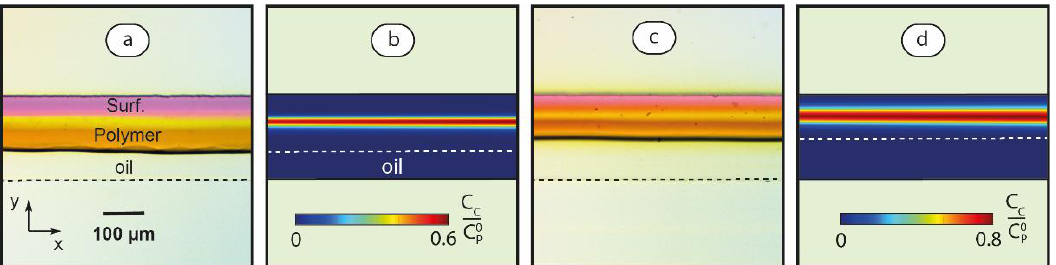
Figure 8. Optical microscopy images and numerical simulation results for PDADMAC-SDS association in linear threads at Ca ≈ 0.05 and different flow rate ratios: φ = 3 ( a , b ) and φ = 1 ( c , d ). C C is the concentration of surfactant ions bound to macrochain binding sites, C P0 is the total concentration of macrochain binding sites. (phenolphthalein + 0.01 M KOH and iodine) were added to surfactant and polymer solutions, respectively, for visualization. Dashed lines mark microchannel boundaries.